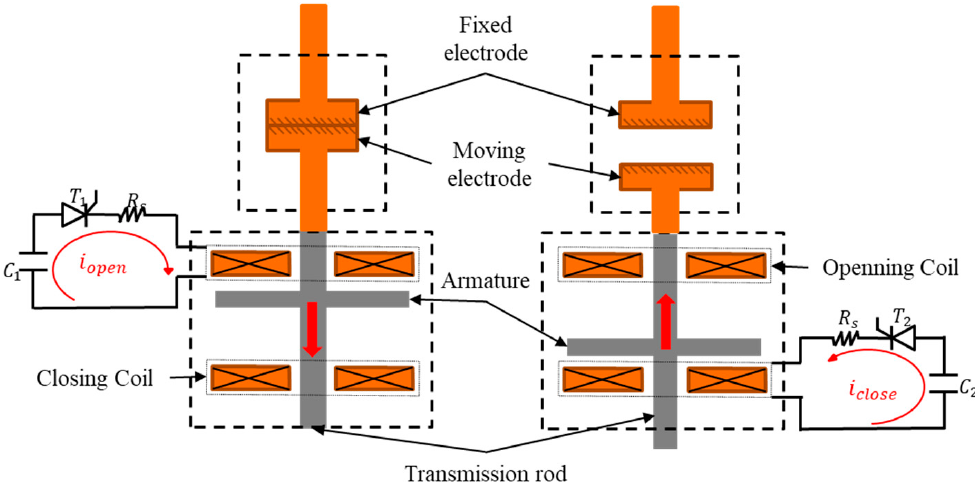
Figure 4. Two-way TCA repulsion mechanism [71].